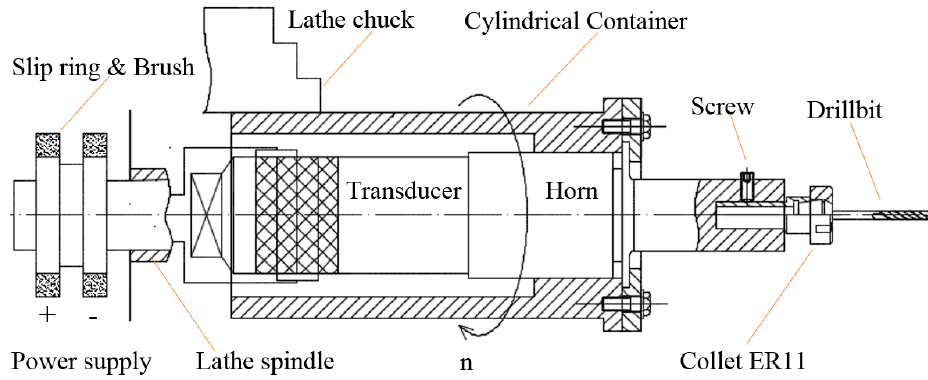
Figure 2. A drawing of the rotary ultrasonic-assisted drilling (UAD).